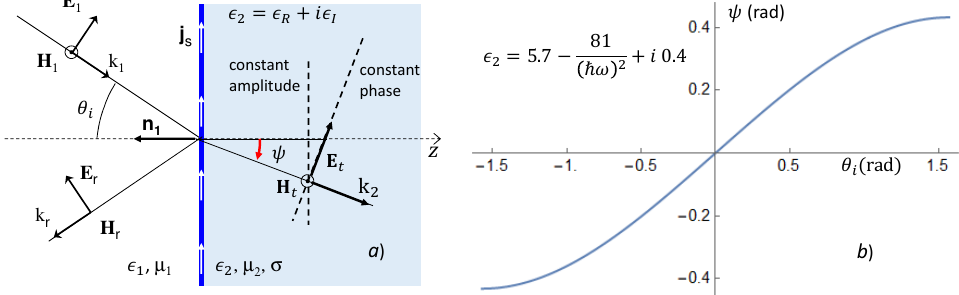
Figure 1. ( a ) Incoming, reflected, and transmitted fields at the interface dielectric-conductor. ( b ) The incidence angle θ i and the effective refraction angle ψ for a silver slab with the dielectric constant shown